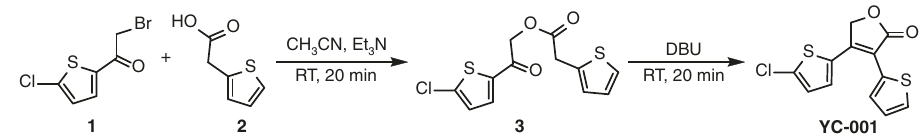
Fig. 9 Synthesis of YC-001. YC-001 was synthesized by a two-step reaction. The 2-bromo-1-(5-chlorothiophen-2-yl)ethan ( 1 ) and